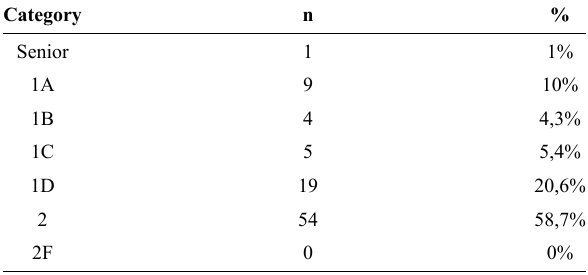
Table 1 - Productivity scholarship category.